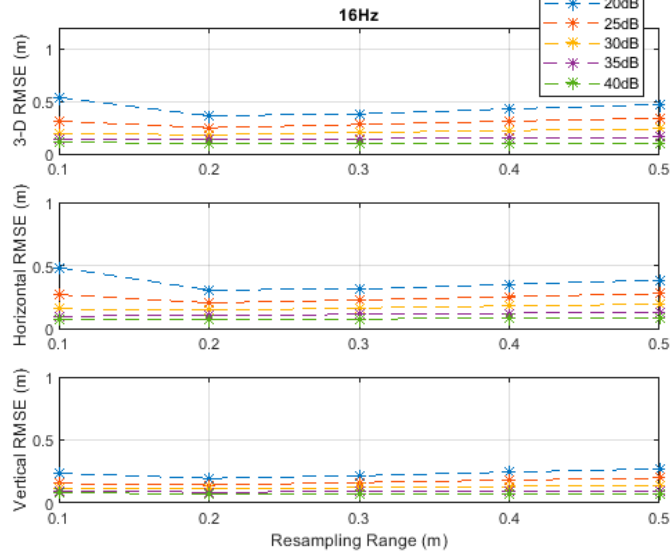
Figure 17. RMSE results along the helical path at a measurement update rate of 16 Hz.